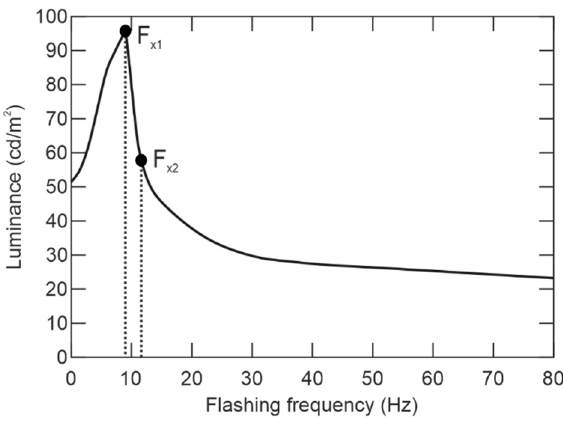
Figure 5. Subjective feeling of perceiving the brightness (adapted from [17]).